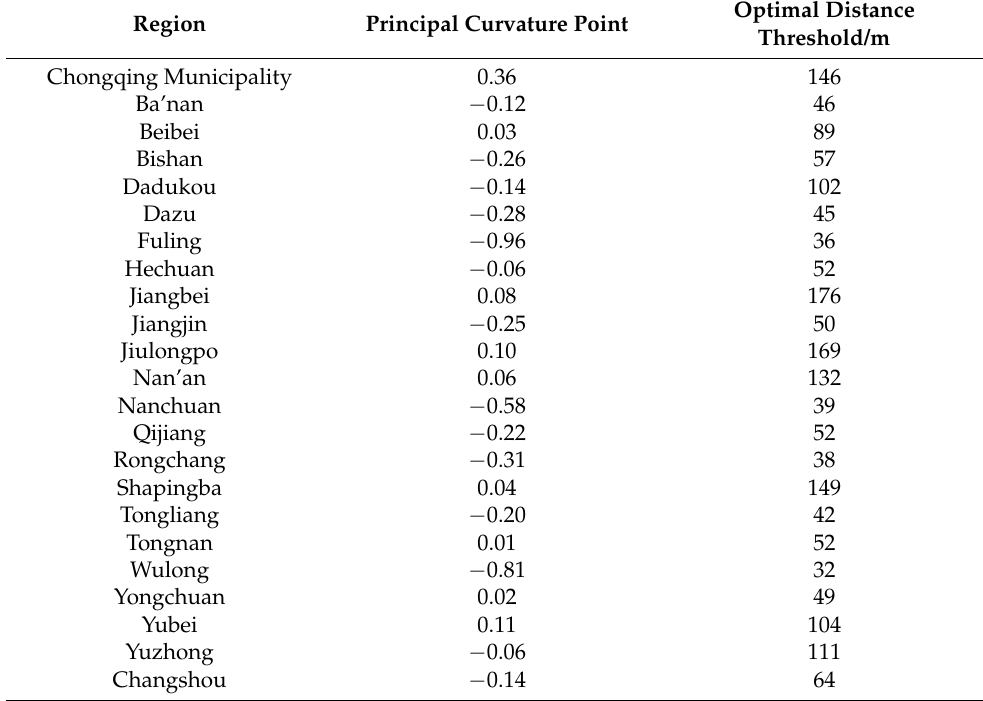
Table 4. Curvature extremum corresponding to distance